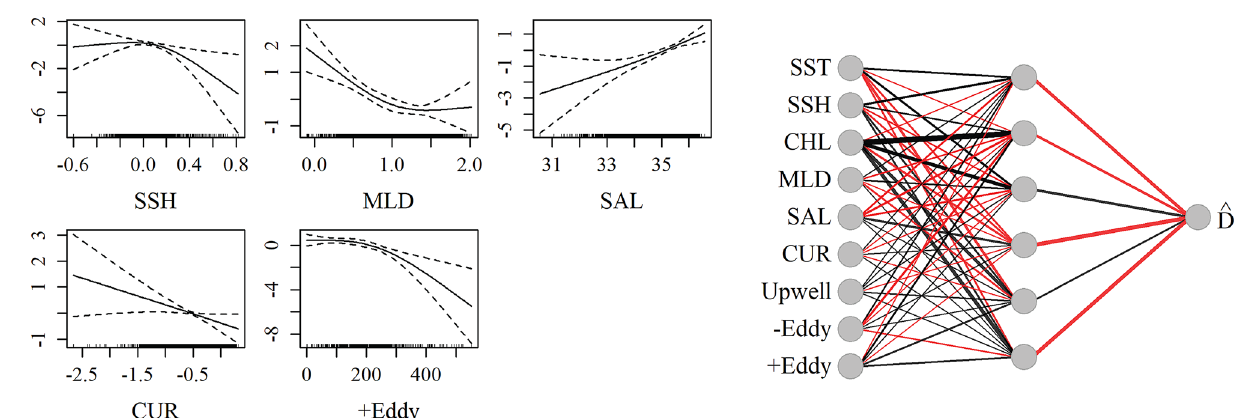
Figure 9. Influence of predictor variables in the best-fitting Risso’s dolphin density models. Left : Smooths of significant terms in the joint GAM. Right : Relative influence of input nodes in the acoustic-only NN. See Fig. 3 for